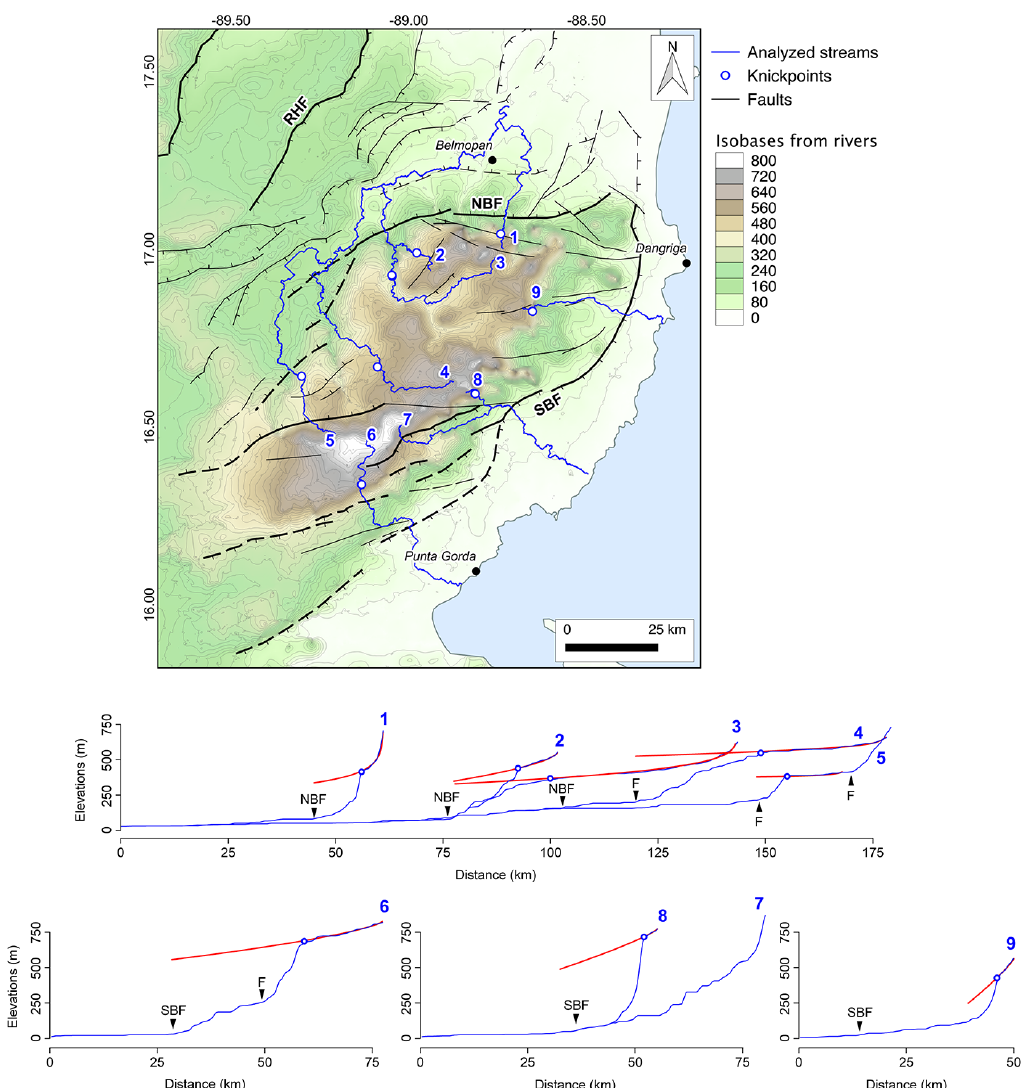
Figure 16. Analysis of drainage network for the Maya Mountains. Top: map of isobases (i.e., interpolated elevations) from rivers with a Strahler order ≥ 2. Main faults (black lines), analyzed streams (blue lines) and main knickpoints (blue dots) are also reported. Bottom: longi- tudinal stream profiles. Blue dots are main knickpoints (location on the map). Red lines show profiles reconstructed using segments located above the knickpoints (see Eq. 7). Black arrows show the intersection with main faults. Abbreviations: NBF – northern boundary fault; SBF – southern boundary fault; RHF – Rio Hondo Fault; F – other